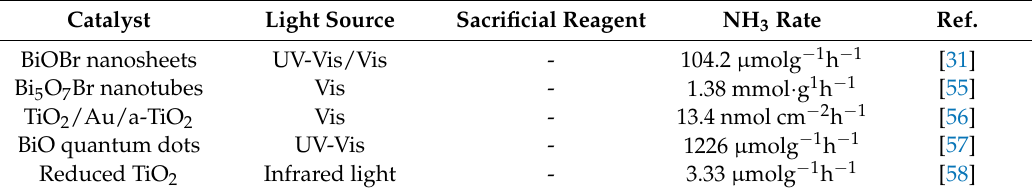
Table 3. Summary of oxide catalysts for the photoreduction of N 2 to NH 3